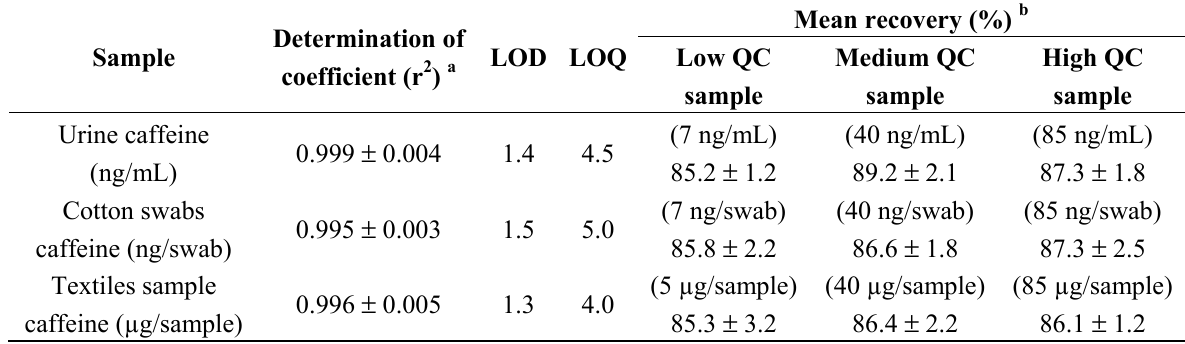
Table 1. Method calibration data and recovery of analyte under investigation.